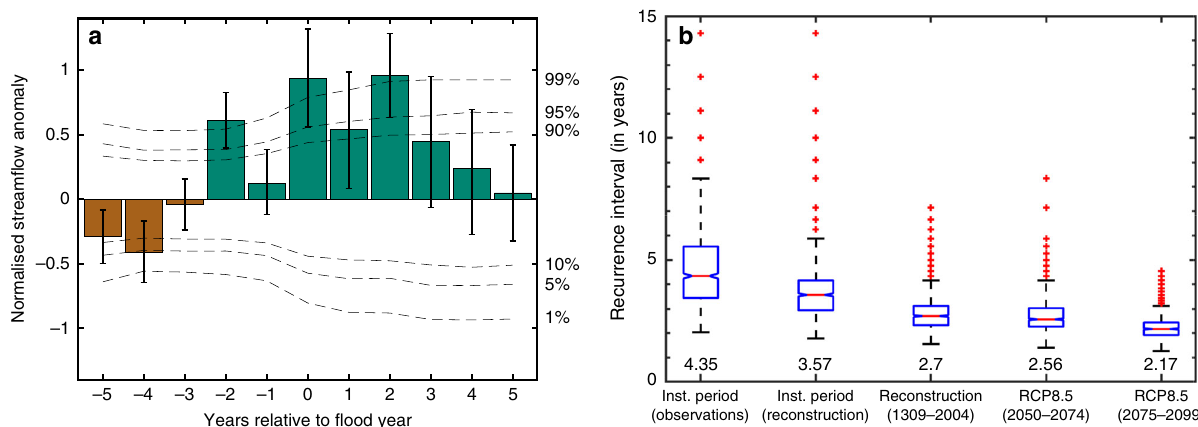
Fig. 4 Discharge characteristics of wet and dry periods and fl ood years. a Superposed epoch analysis (SEA) showing higher than normal fl ows in historical and instrumental period fl ood years (in year t + 0) between 1780 and 2004 C.E. than would be expected by chance. The response is the 5th, 50th, and 95th percentiles of mean fl ow across 1000 unique draws of 10 fl ood years at random out of 16. The horizontal dotted lines indicate the threshold required for epochal anomalies to be statistically signi fi cant using random bootstrapping at three different statistical thresholds. These thresholds were calculated by compositing 10,000 draws of 10 years at random (or ‘ pseudo- fl ood years ’ ) from the reconstruction between 1780 and 2004 C.E. b Recurrence